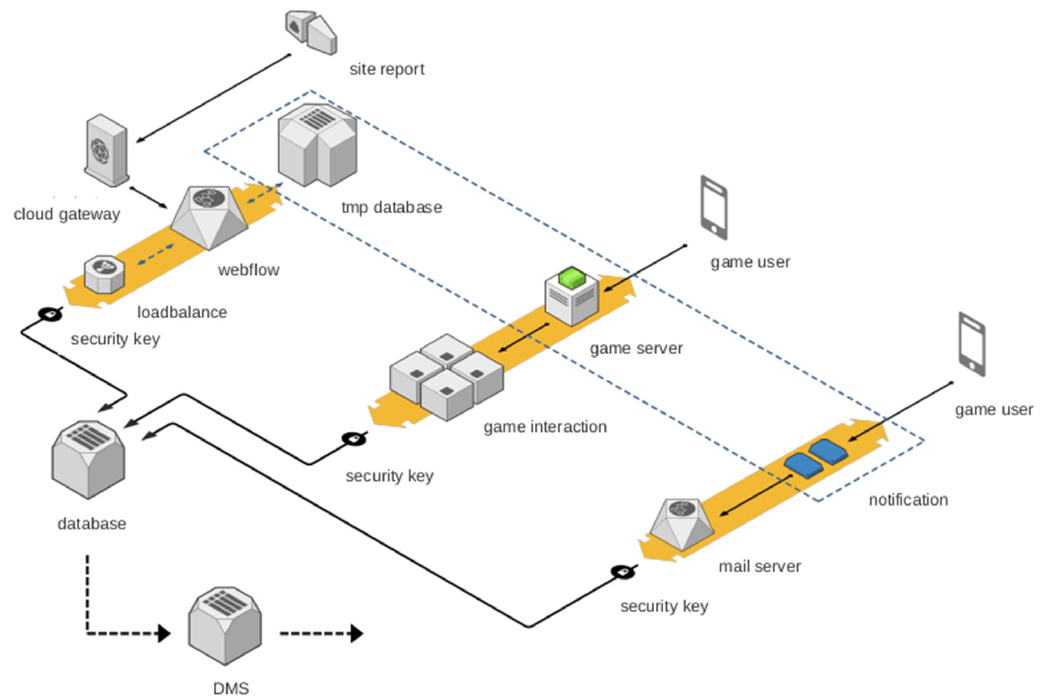
Figure 1. Architecture for the server that hosts the game tool.